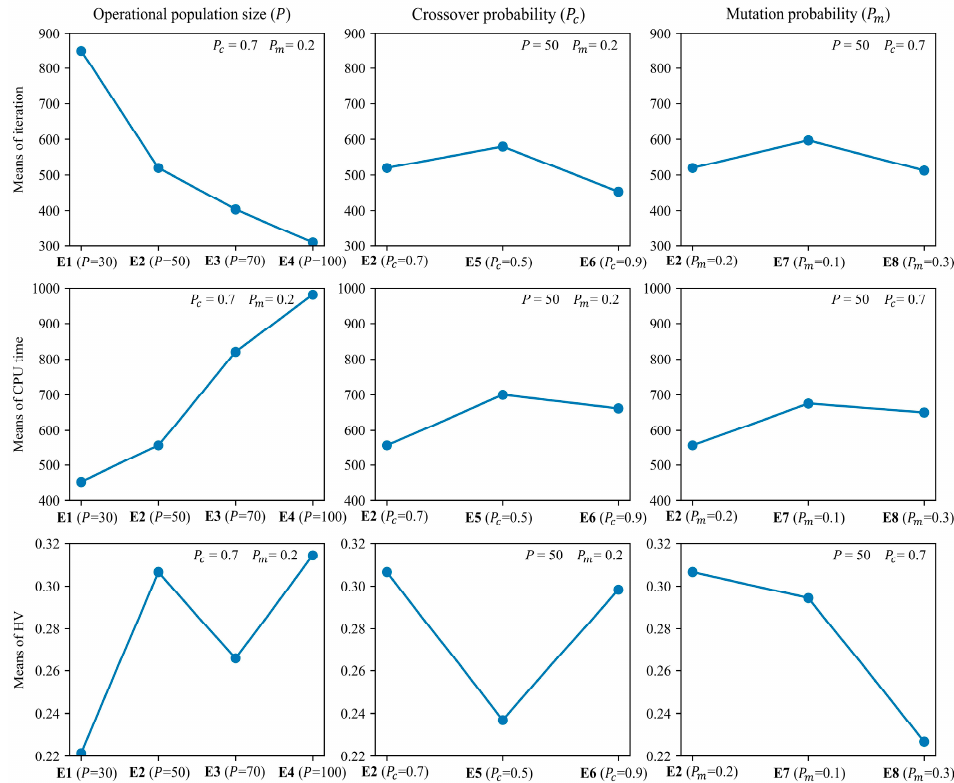
Figure 7. Algorithm evaluation results under different parameters. The three vertical columns are the controlled trial experiments on different kinds of parameters, including P , P c , and P m . The three horizontal rows demonstrate the indicators of the experiment results to evaluate the algorithm’s performance under different parameters, including average iteration times, average CPU time, and average HV.